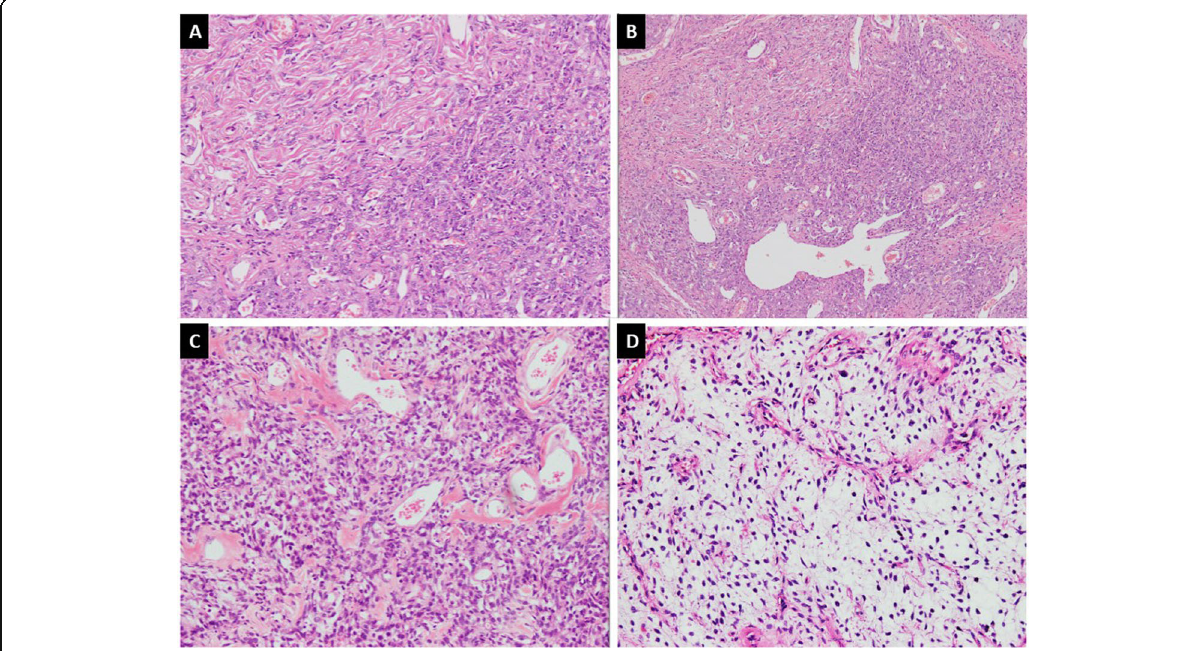
Fig. 2 a . SFT exhibiting hypo and hypercellular areas of spindle cells against collagenous background stroma along with, b . HPC-like vessels, c . stromal and perivascular fibrosis and, d . myxoid change in